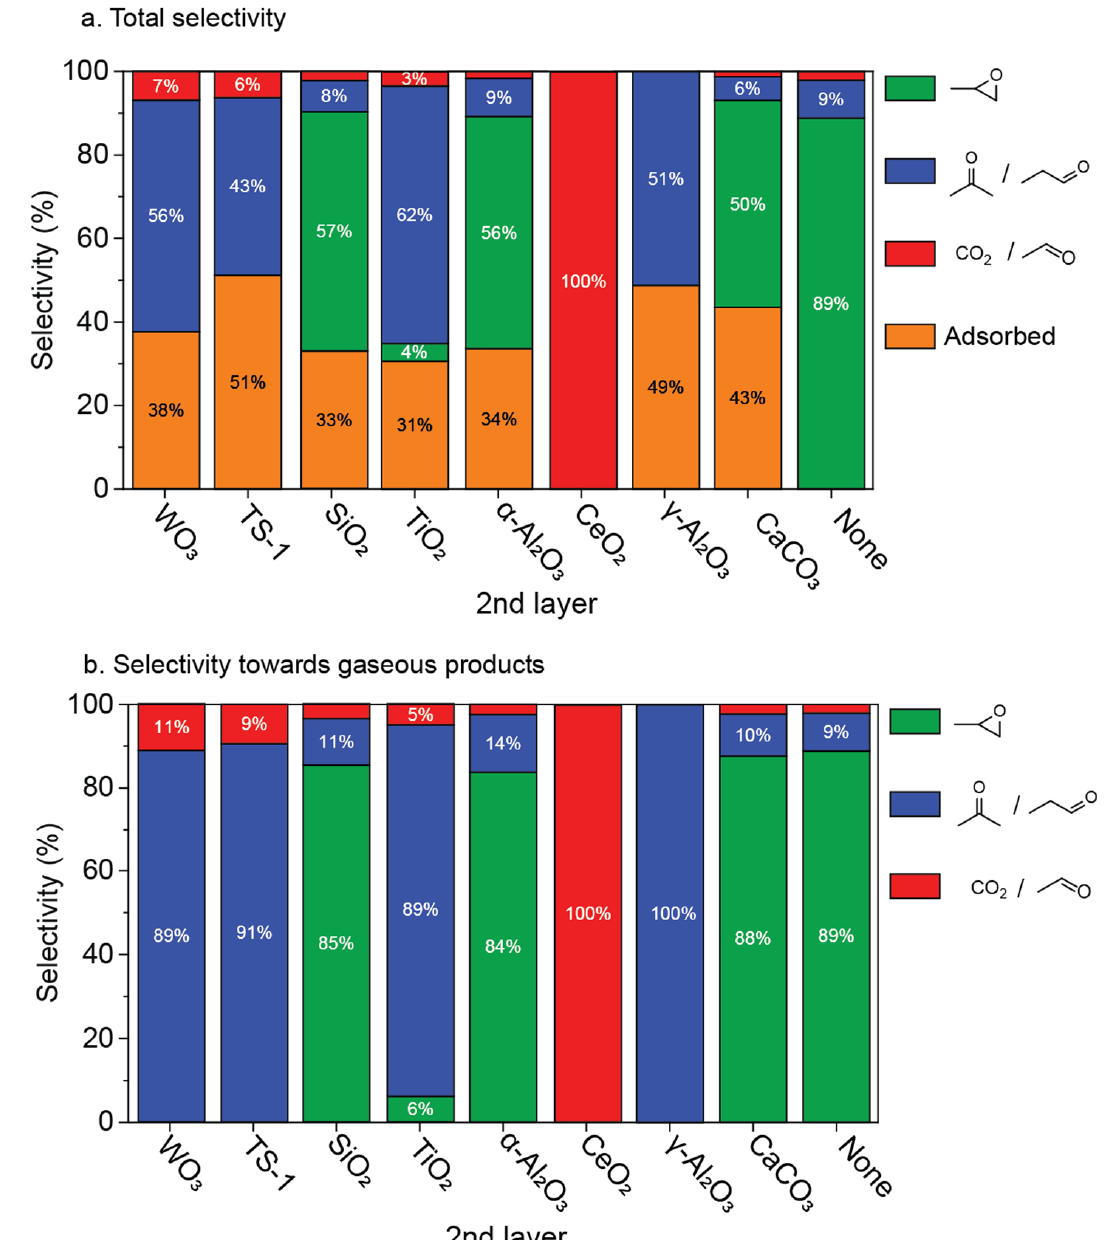
Figure 7. Stacked bed experiments where different support materials exposed to a gas feed containing PO. ( a ) Total selectivity, ( b ) selectivity towards gaseous products. Conditions: 75 mg of Au/TS- 1 catalyst, 150 mg of support material, 10,000 mL/g support /h flow of 10% of each C 3 H 6 , O 2 and H 2 in He at 200 °C, the selectivity was the average between 2–3 h of testing .